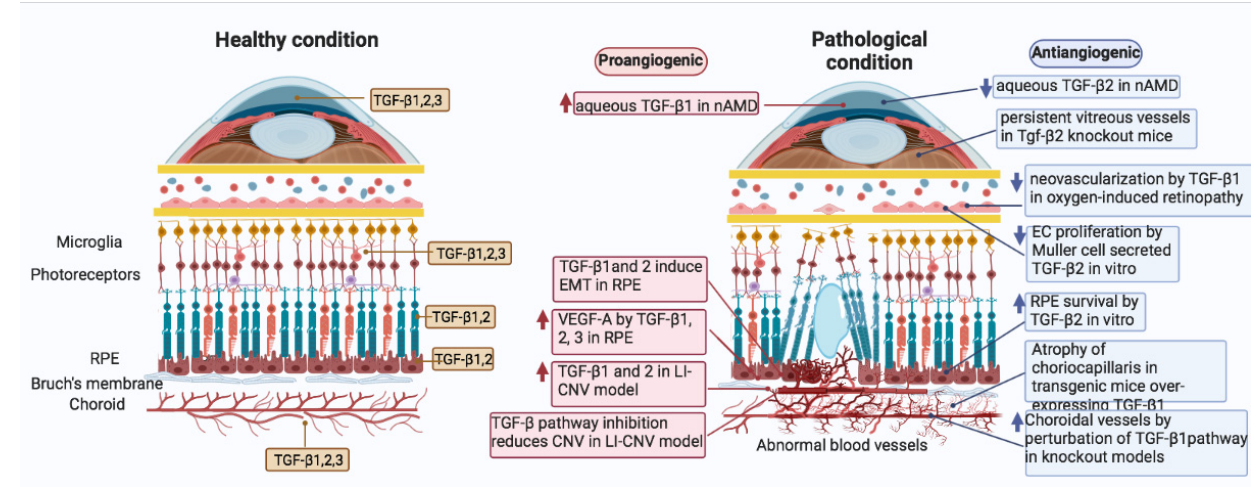
Figure 2. Graphic representation of the implications of TGF- β signaling in the pathological processes occurring during the progression of age-related macular degeneration. Schematic representation summarizing the TGF- β 1, TGF- β 2, and TGF- β 3 expression in healthy condition in human eye structures and cells ( left ) and proangiogenic and antiangiogenic expression of TGF- β 1, TGF- β 2, and TGF- β 3 in nAMD of human eye structures ( right ). The squares in blue or red indicate, respectively, down-regulation and up-regulation of different types of TGF- β with the related site in the eye. nAMD: neovascular age-related macular degeneration. EMT: epithelial to mesenchymal transition. RPE: retinal pigment epithelium. CNV: choroidal neovascularization.